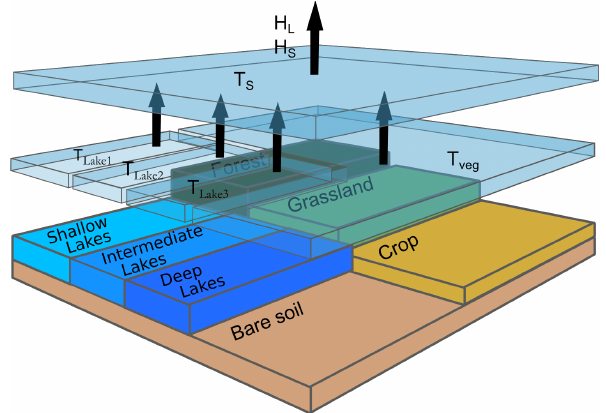
Figure 1. Multi-tile lake representation in the ORCHIDEE land sur- face model in a three-tile